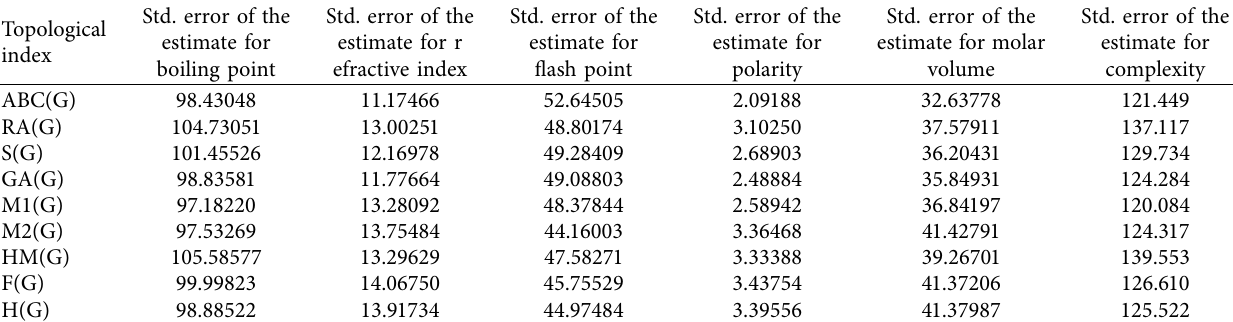
Table 13: Standard error of